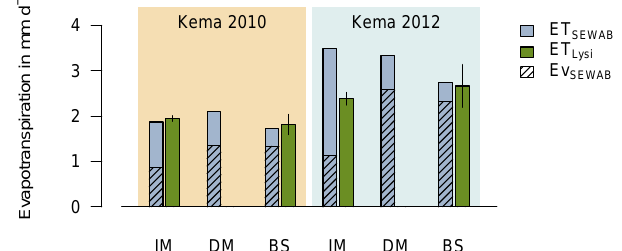
Figure 3. Evapotranspiration (ET) derived with SEWAB and with micro-lysimeter measurements at Kema in 2010 (33 days: 23 June–25 July) and Kema in 2012 (40 days: 16 July–24 August) for intact root mat (IM), degraded root Mat (DM) and bare soil (BS). Hatched bars denote the simulated evaporation (Ev) as part of the total simulated ET, the remainder is transpiration. Black lines on top of the bars for the micro-lysimeter illustrate standard deviations ( n =